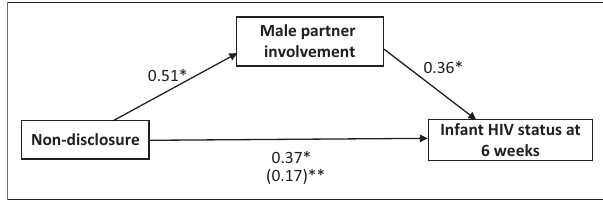
FIGURE 4: Regression coefficients for relationship between non-disclosure and HIV status at 6 weeks as mediated by male partner